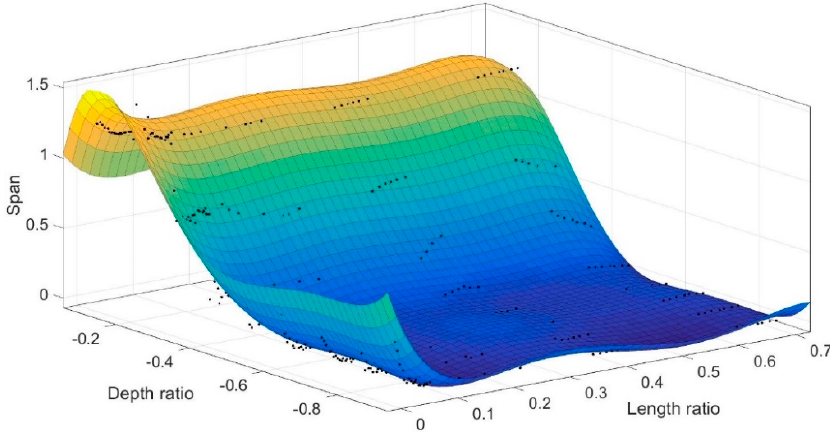
Figure 5. Fitted 3D plot of the drop function with regards to length ratio l c / l 0 and depth ratio d / l 0 .